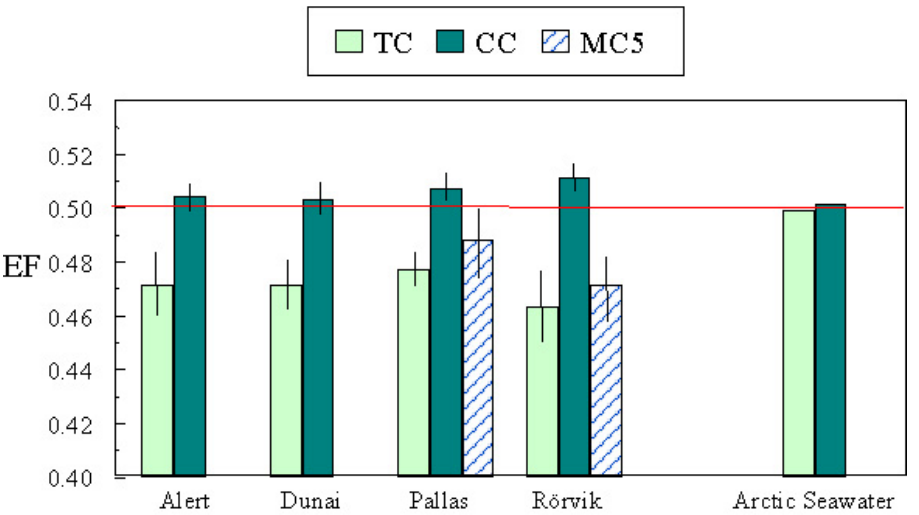
FIGURE 4. Enantiomer fractions of TC, CC, and MC5 in arctic air and seawater. Vertical lines indicate standard deviations. Air data from Bidleman et al.[73], water data from Jantunen and Bidleman[18]. Air-Water